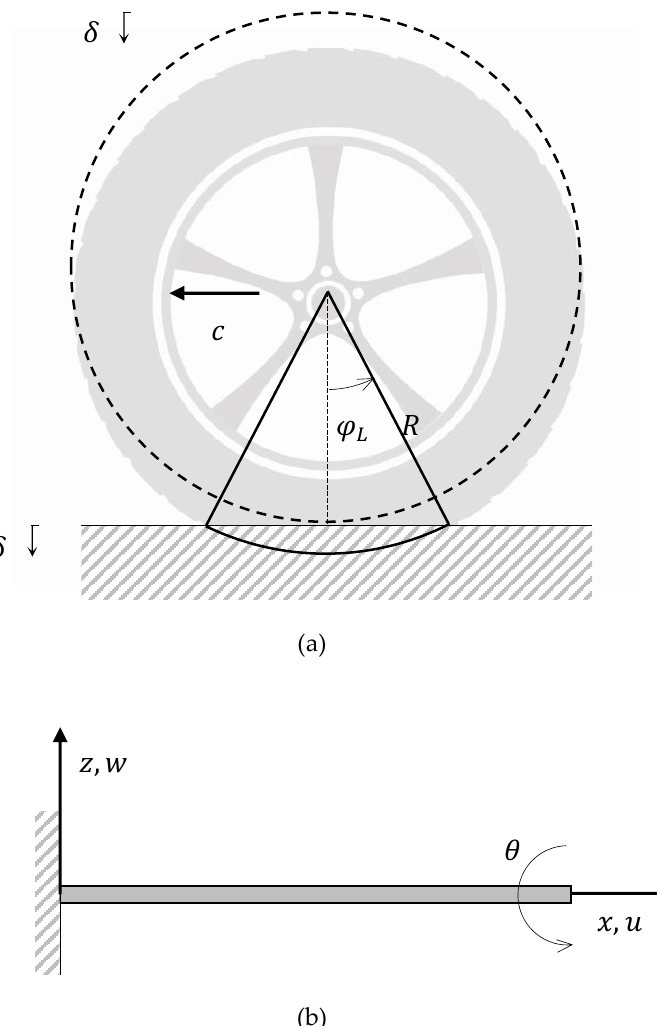
Figure 5. ( a ) Reference systems of the rolling tyre; ( b ) reference systems of the elastic beam.